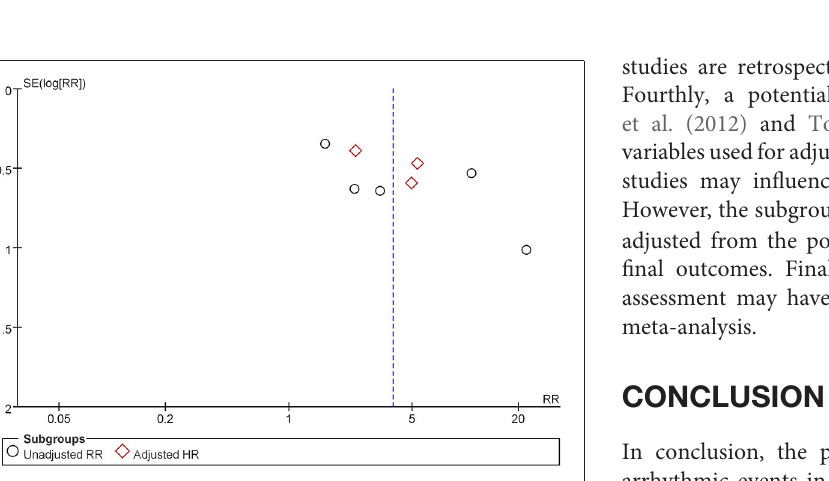
FIGURE 3 | Funnel plot of the